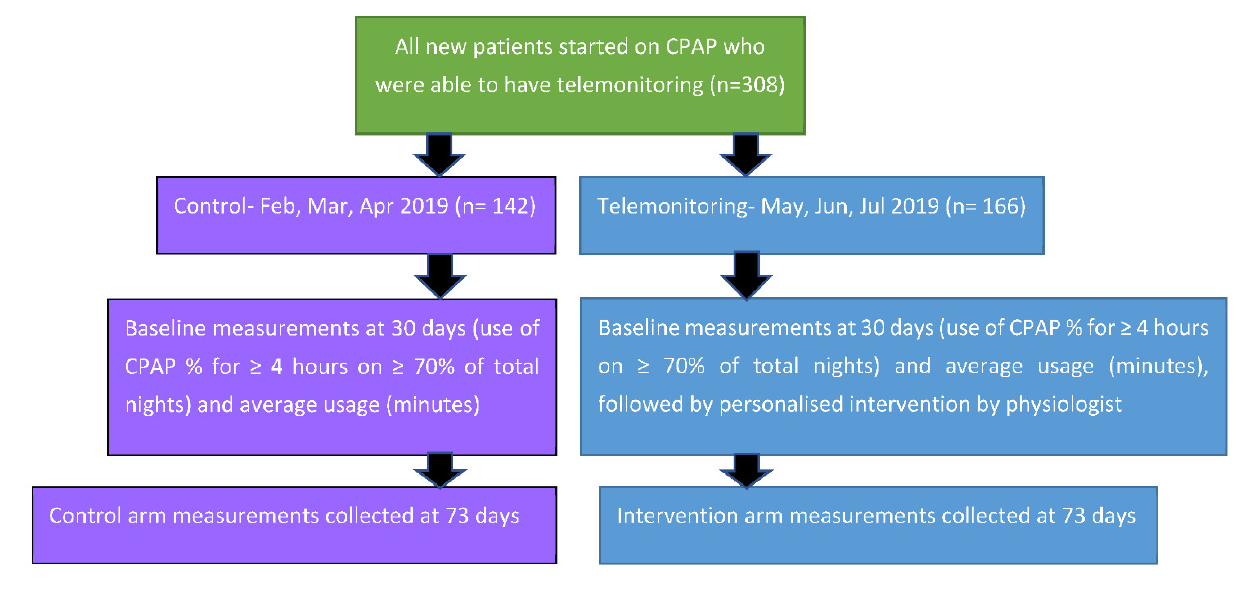
Figure 2. Schematic representation of the design of the Service Improvement Project and timeline of measurements.